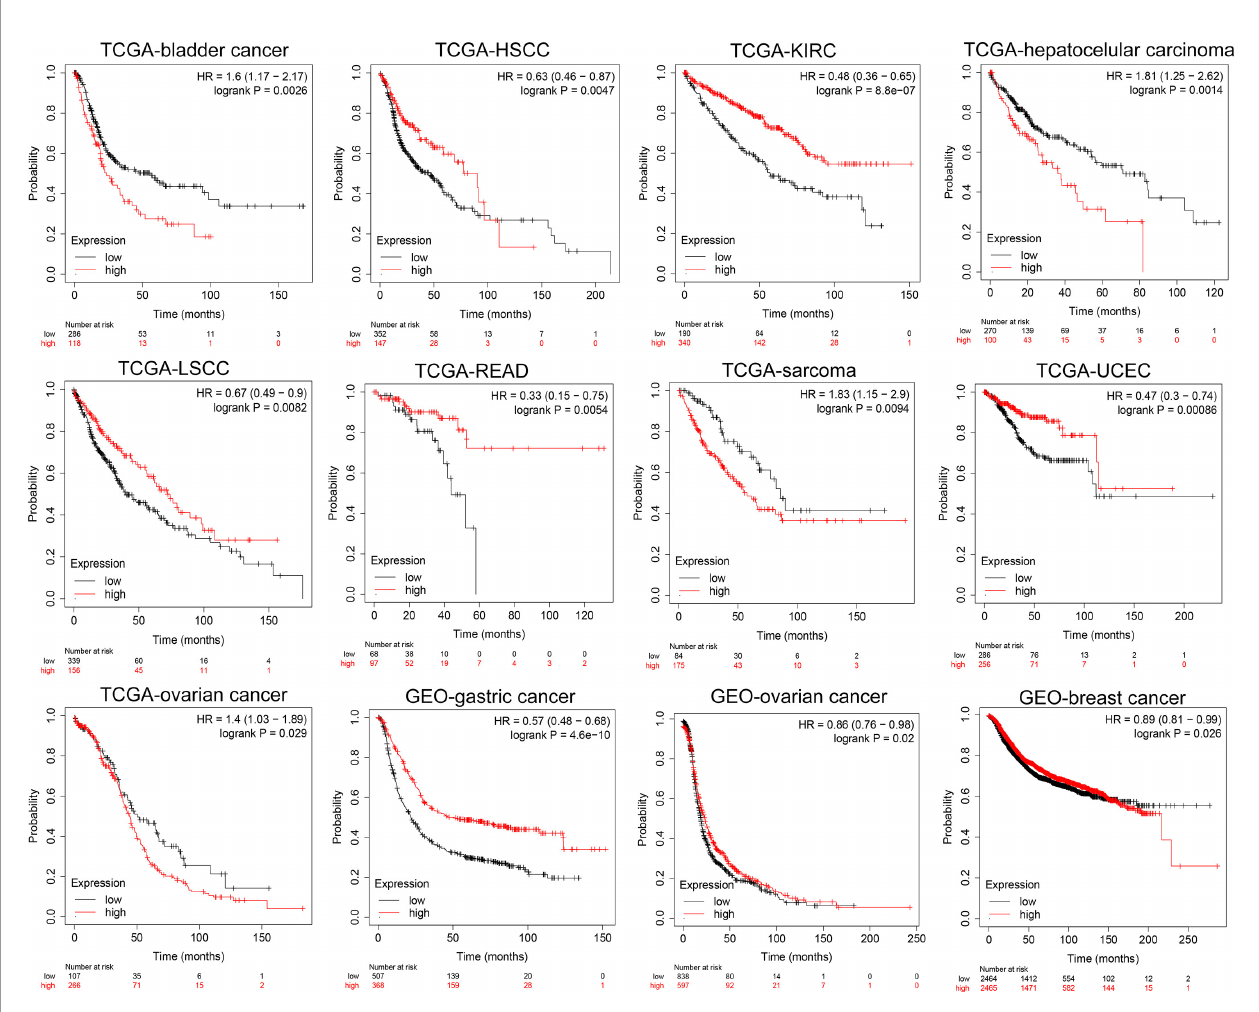
FIGURE 5 | Subgroup survival analysis indicated that high expression of NKCC1 is associated with poor survival for pan-cancer patients. Bladder cancer (HR = 1.60, p = 0.0026, TCGA), LIHC (HR = 1.81, p = 0.0014, TCGA), sarcoma (HR = 1.83, p = 0.0094, TCGA), ovarian cancer (HR = 1.41, p = 0.029, TCGA), HSCC (HR = 0.61, p = 0.0047, TCGA), KIRC (HR = 0.48, p < 0.001, TCGA), LSCC (HR = 0.67, p = 0.0082, TCGA), READ (HR = 0.33, p = 0.0054, TCGA), UCEC (HR = 0.47, p < 0.001, TCGA), gastric cancer (HR = 057, p < 0.001, n = 875, GEO), and breast cancer (HR = 0.89, p = 0.026, n = 4,929,